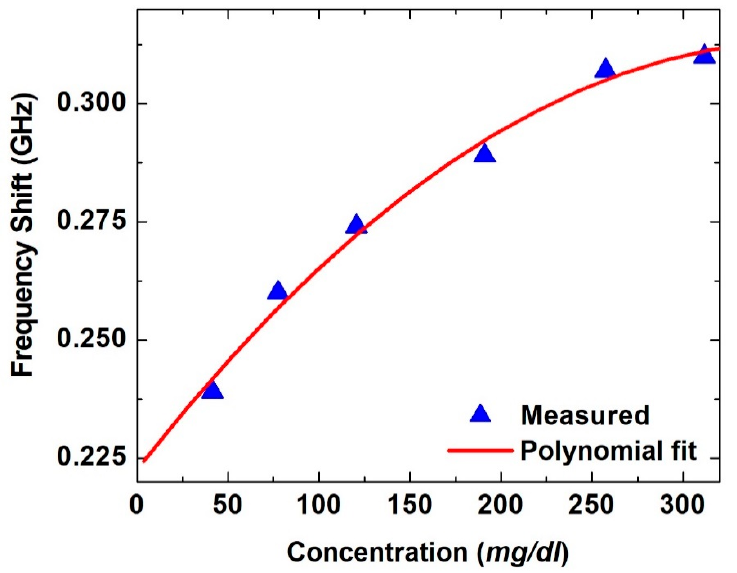
Figure 6. Frequency shift versus glucose concentration level for the six samples with a second-order polynomial fitting model and R 2 = 0.997. Table 1. Parametric comparison of various microwave sensors for glucose level evaluation.